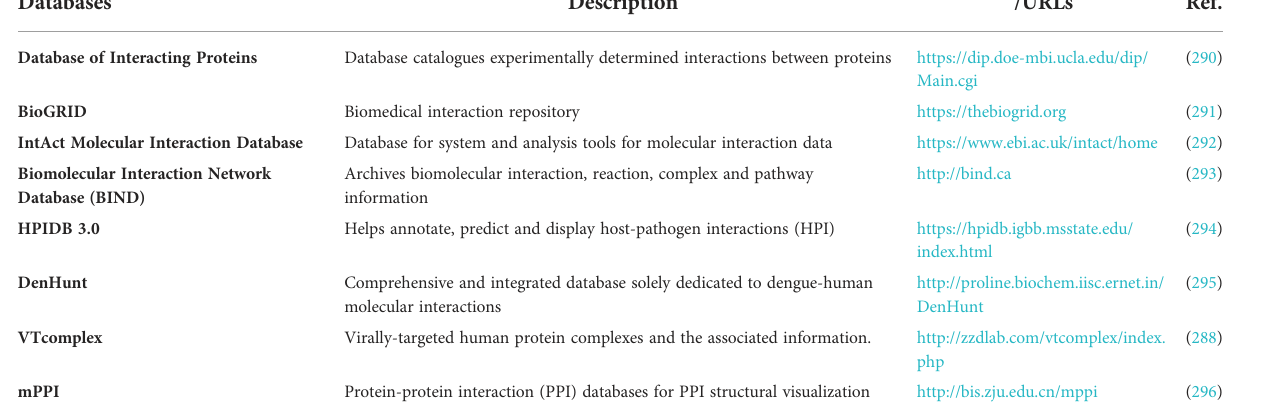
TABLE 8 Description of different databases used to study protein-protein